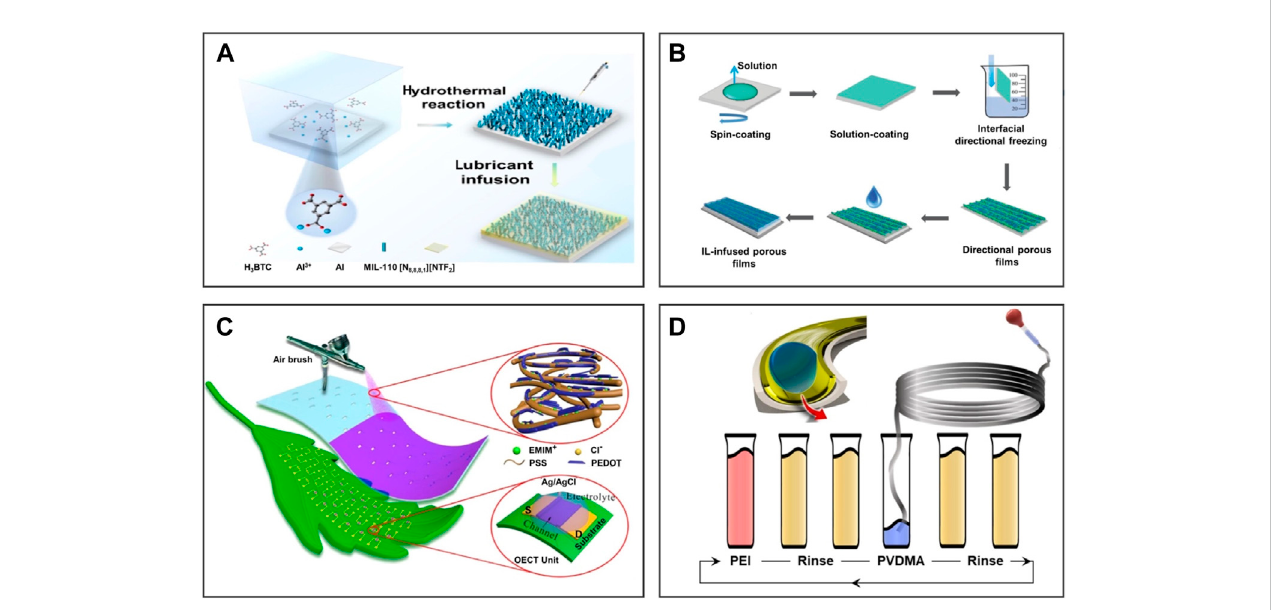
FIGURE 3 Preparation methods of 2D IL-infused porous surfaces. Schematic diagram of the IL-infused porous surface obtained via the hydrothermal method, freeze – drying, spraying, and layer-by-layer method. (A) The hydrothermal method is a process of precursor chemical reaction on the substrate under high temperature and high-pressure conditions. (B) The interfacial directional freezing technique is usually used to prepare porous materials with anisotropic interfaces. (C) Spraying – depositionisaprocessofsprayingsolutiontothesubstratesurfacethroughasprayguntoobtaincoating. (D) Thelayer-by-layer suction fl ow method is suitable for apipe, which uses an external injection apparatus to slowly and evenly infuse solution into thepipe. (A) is reproduced with permission(Lietal.,2022).Copyright2021,ElsevierInc.; (B) reproducedwithpermission(WangZ.etal.,2018).Copyright2018,WILEY-VCHVerlagGmbHand Co. KGaA, Weinheim; (C) reprinted with permission (Wu et al., 2020). Copyright 2020, American Chemical Society; (D) reproduced with permission (Agarwal et al., 2021). Copyright 2021, American Chemical